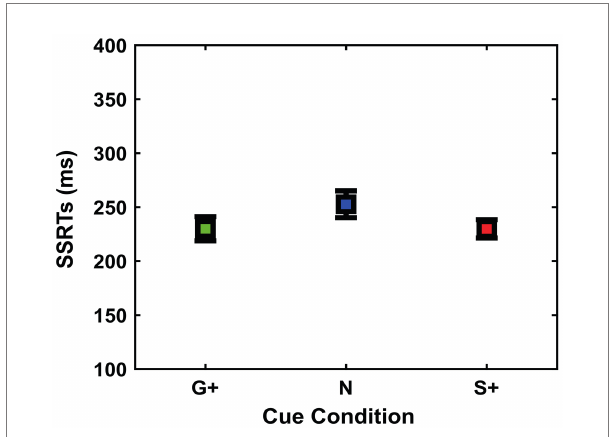
FIGURE 3 Stop signal reaction time [SSRT (ms)] (mean and ± 1SEM) estimated in the different cue conditions (G+, N, S+).